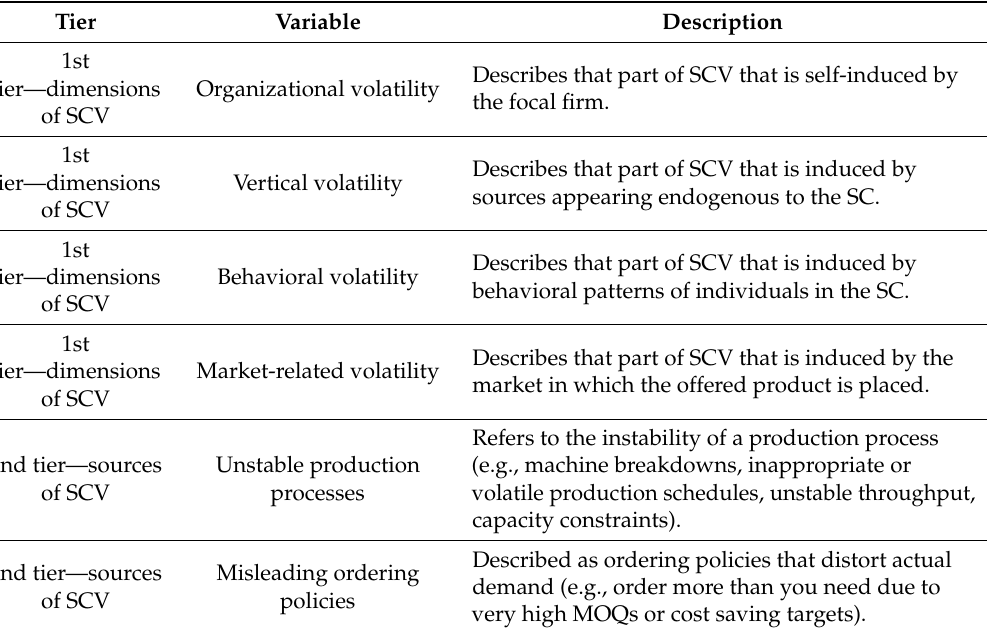
Table 1. Description of dimensions and sources of